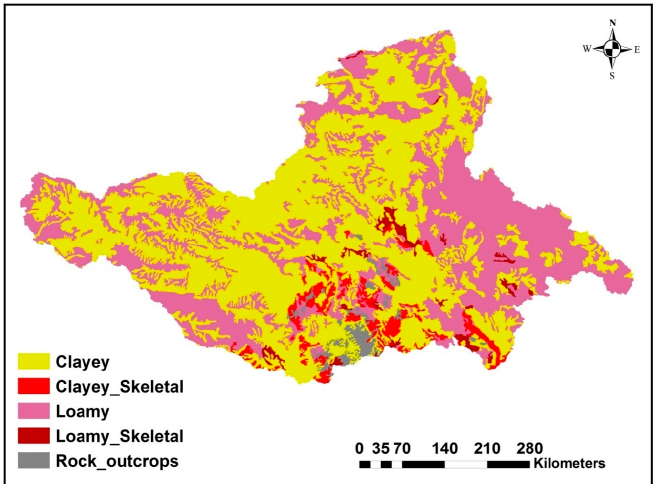
Figure 3. Soil map of the Godavari Basin.